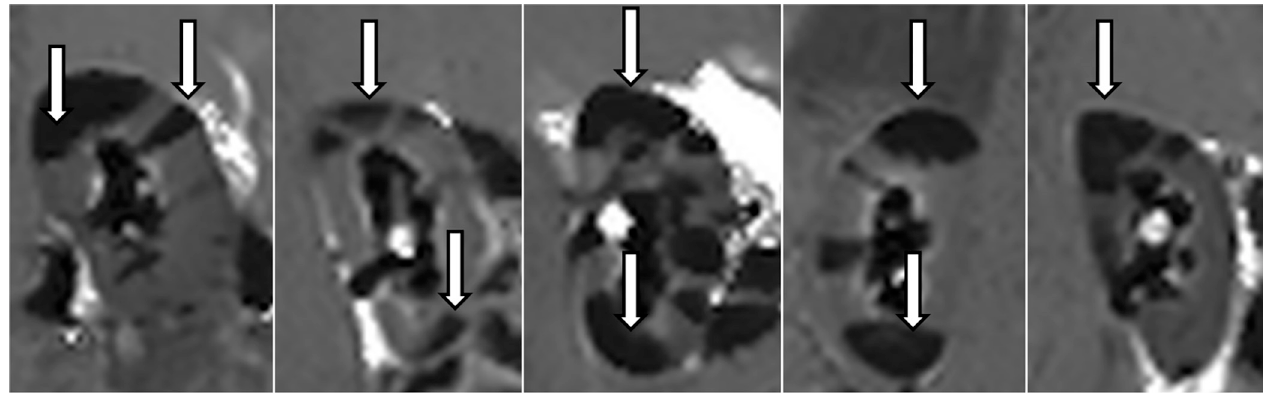
Fig 5. Final MR scan. Final MR-scan for the 5 animals showing widespread T1 changes as dark areas (arrows) due to increased intraluminal pressure in the treated kidneys. Time range 60–80 mins; pressure range 20–54 mmHg. In animal no. 4 the study was performed on the right kidney due to ureteral catheter placement failure on the left side. 1: 72 min—51 mmHg 2: 60 min– 20 mmHg 3: 80 min– 40 mmHg 4: 80 min– 50 mmHg 5: 60 min– 54 mmHg.